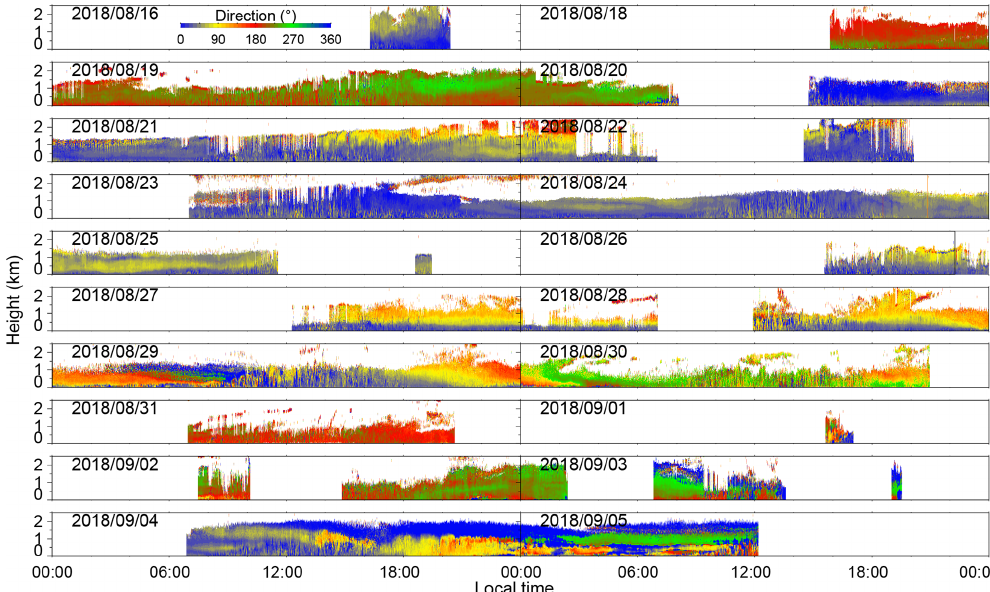
Figure A3. Similar to Fig. A1 but for horizontal wind direction.